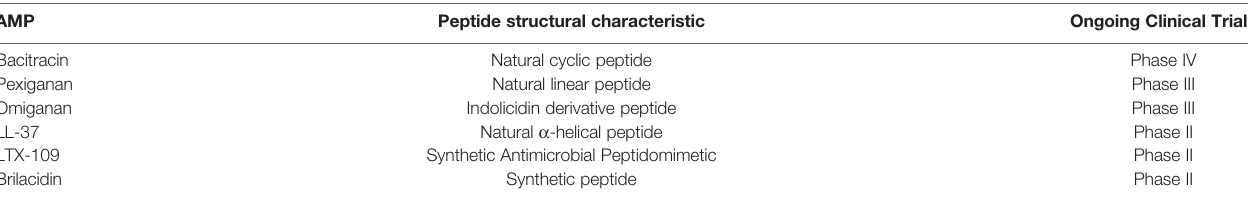
TABLE 3 | List of the AMPs in ongoing clinical trials. AMP Peptide structural characteristic Bacitracin Natural cyclic